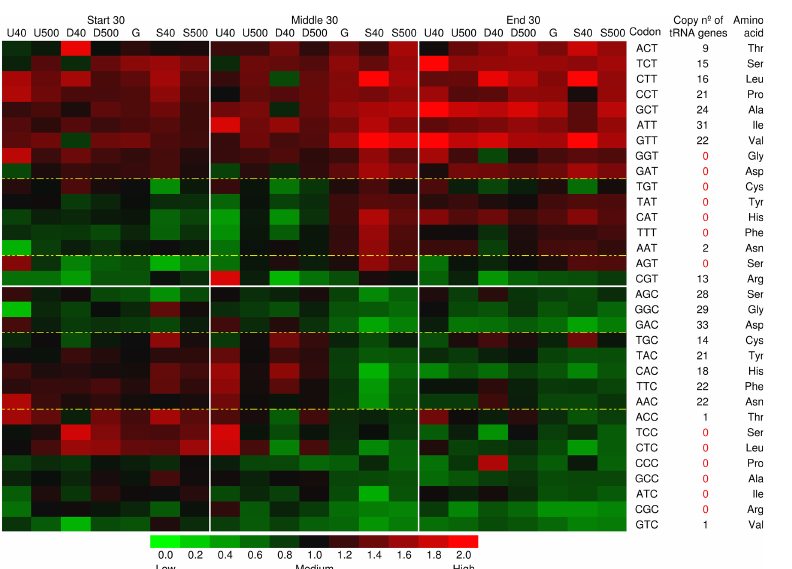
Fig 7. Heat map of relative synonymous codon usage (RSCU) for start, middle, and end 30 CDS (coding sequence) codons ending in pyrimidine (C and T) from different soybean gene groups. The groupsare formed by top 40 and 500 ranked up- (U), down-regulated(D), and stable-genes (S) to hypoxia, and genome(G). Asp, Cys, Tyr, His, Phe, and Asn are codingby 2-fold degeneratepyrimidine endingcodons. Heat map of RSCU for all 59 synonymous codons including for whole CDS extensionis providedin Fig E in S1 SupportingInformation.